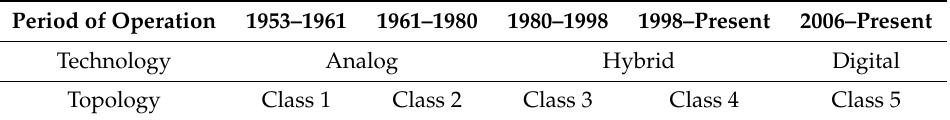
Table 1. Technological and topological evolution of the SRC seismic network from 1953 to now. Period of